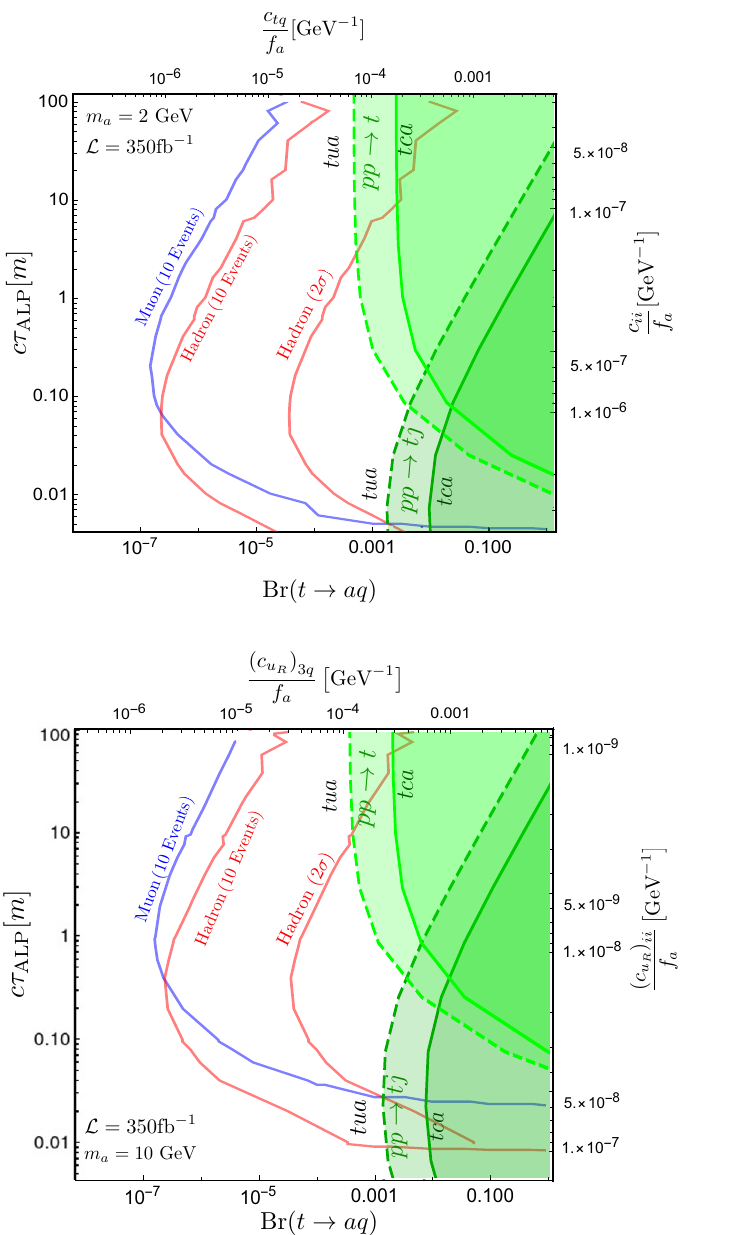
Figure 6 . The expected bounds as a function of lifetime ( cτ ALP ) and the branching ratio of the exotic top decay Br ( t → aq ) , for m a = 2 GeV (top) and m a = 10 GeV (bottom). The red line labeled with ‘Hadron 2 σ ’ represents the conservative limit (table 1) where S √ L = 350 fb − 1 integrated luminosity. The red (blue) solid line is the potential discovery line where 10 signal events are produced in the hadronic (muon) calorimeter, in case a background free search can be designed. Finally, the green shaded regions indicate the current bounds on the model. The dark green lines are derived from the top + jet [65] final state, and the light green lines are from the single leptonic top search [73, 88]. The dashed lines are for the constraints on the tua coupling, and the solid ones are that of the tca